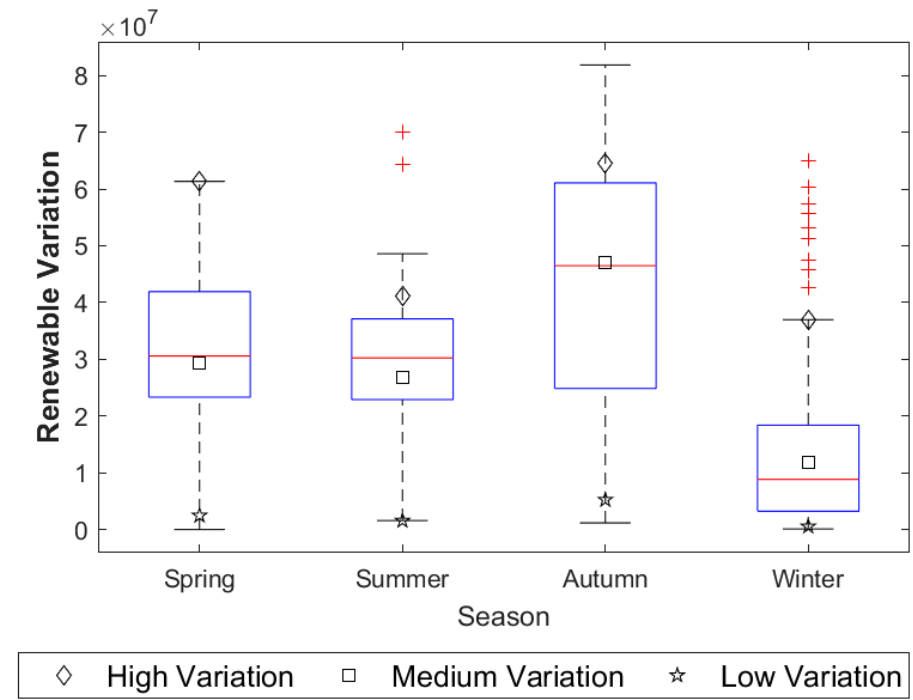
Figure 5. Scenarios of renewable energy variations in four seasons.